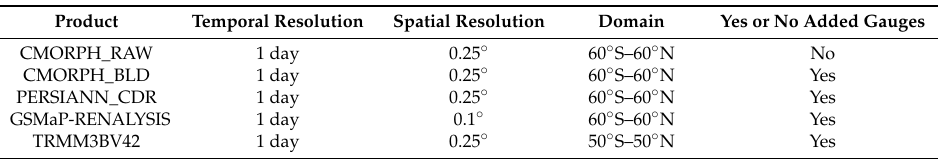
Table 1. Description of the precipitation datasets utilized in this study.